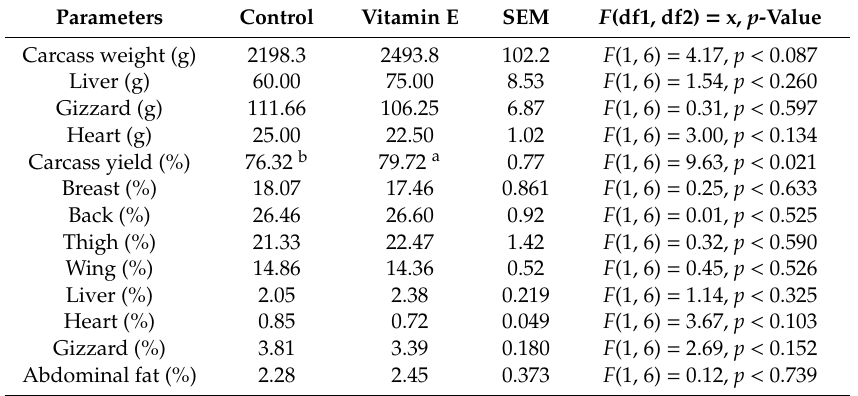
Table 4. E ff ect of vitamin E supplementation on carcass parameters of 56-day-old male geese. Parameters